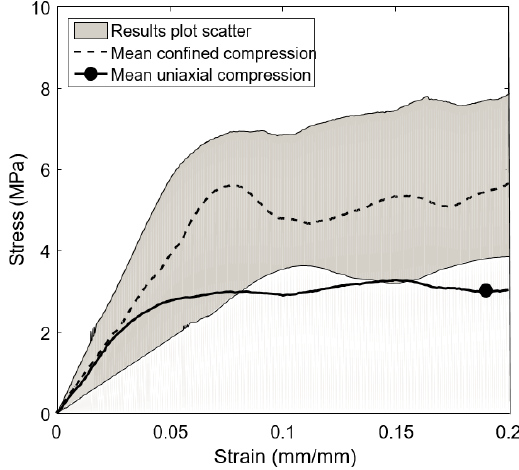
Figure 8. Stress – strain curves of confined compression tests vs. uniaxial compression tests.